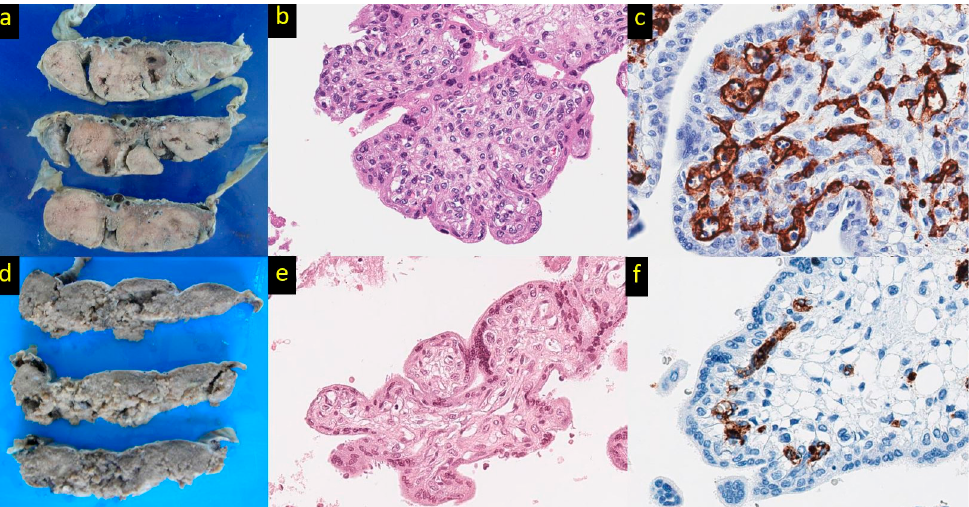
Figure 1. Placental pathology in Hb Bart’s disease. ( a ) The placenta belonging to Hb Bart’s disease shows enlarged, pale, and edematous cut surfaces in comparison to the placenta of non-Hb Bart’s disease ( d ). ( b ) Immature intermediate villi with a bulbous contour possessing conspicuous myofi- broblasts at the periphery beneath the trophoblastic layer referred to as peripheral villous stromal hypercellularity in comparison to the control ( e ) (hematoxylin and eosin, original magnification ×400). ( c ) A branching vascular pattern with increased vessel number and endothelial thickness in comparison to the control ( f ) (CD34 immunostaining, original magnification ×600).